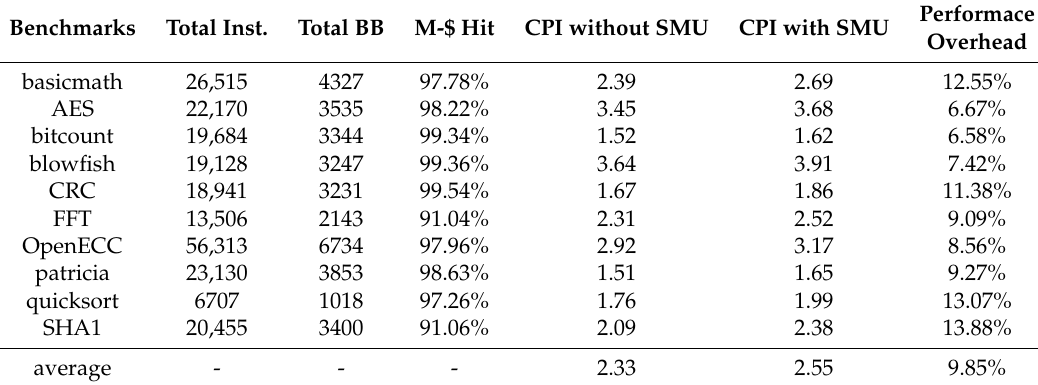
Table 6. Performance overhead of processor configured with SMU.